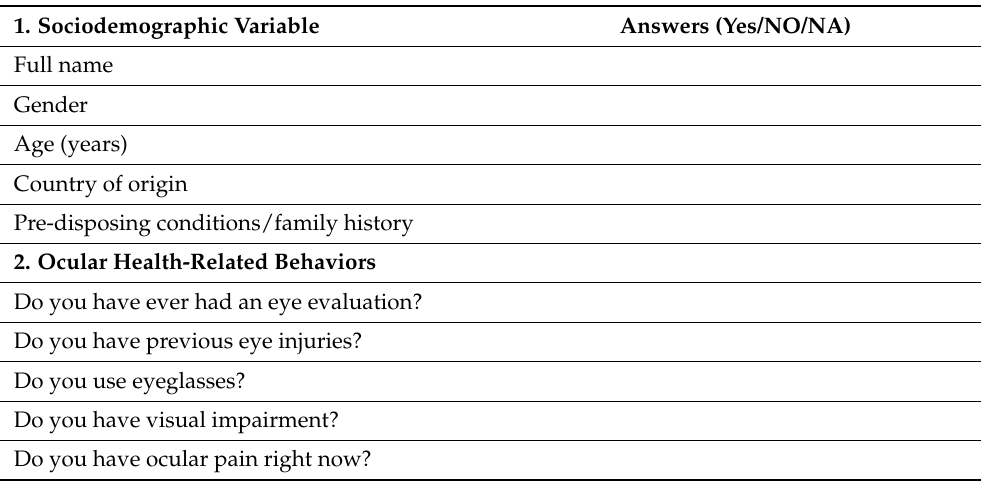
Table 1. Questionnaire applied at the time of enrollment to assess ocular